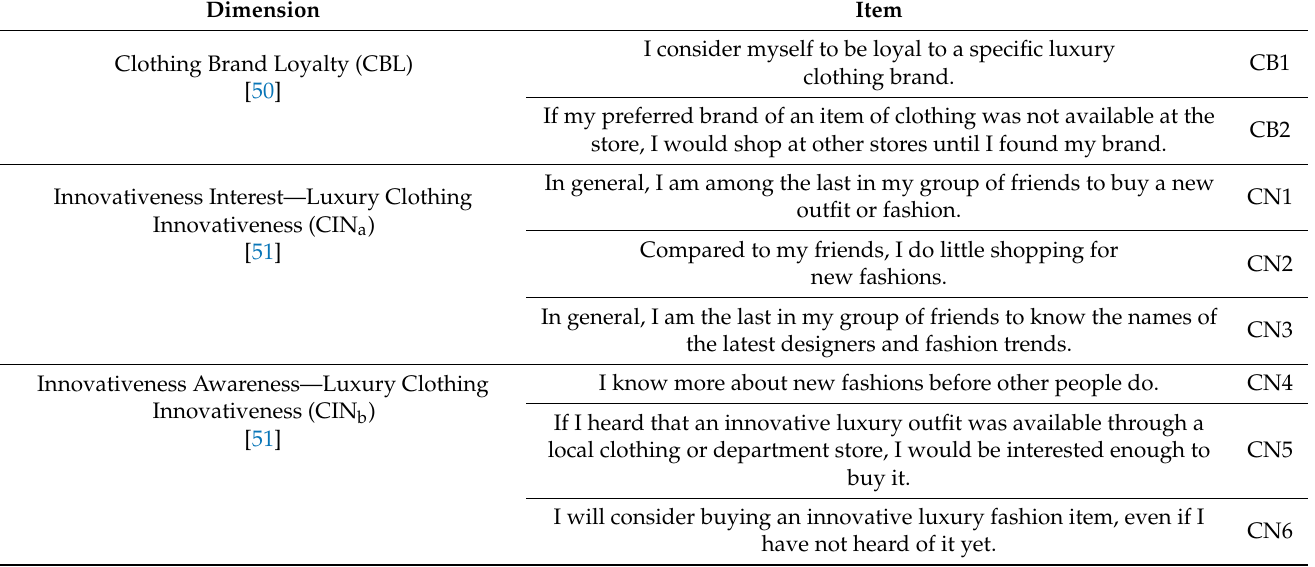
Table 2. Outcome variables: clothing brand loyalty and luxury clothing innovativeness.